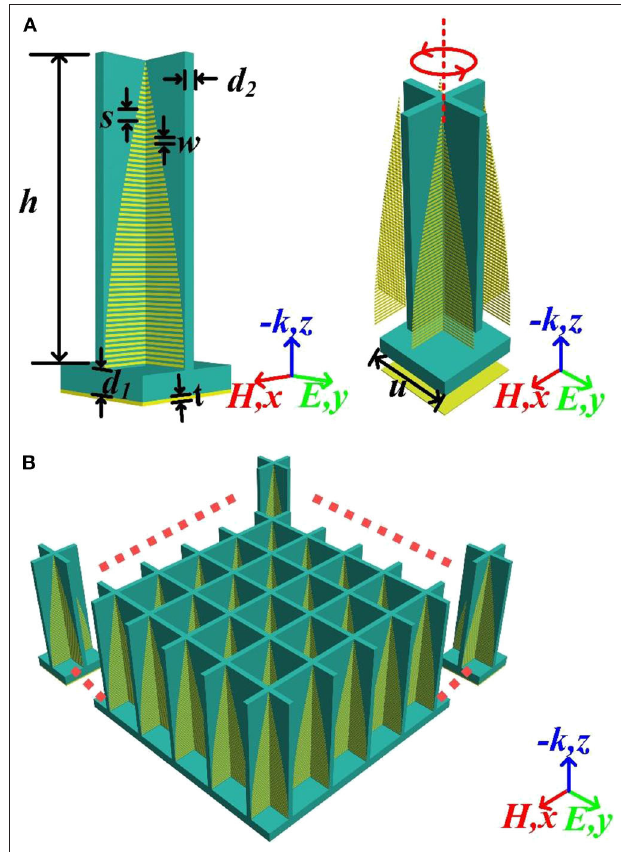
FIGURE 2 | Schematic of straight-strip-shaped APS. (A) The design of absorber unit and (B) the complete absorber is consisted of absorber units.